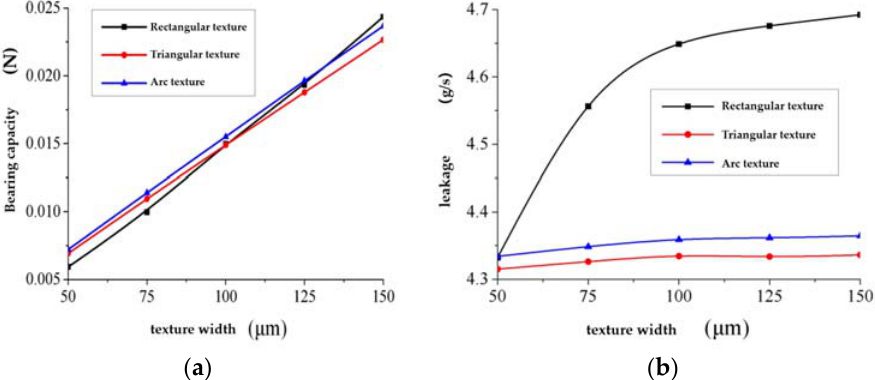
Figure 10. Effect of texture width on sealing performance. ( a ) Effect of texture width on bearing capacity; ( b ) Effect of texture width on leakage.